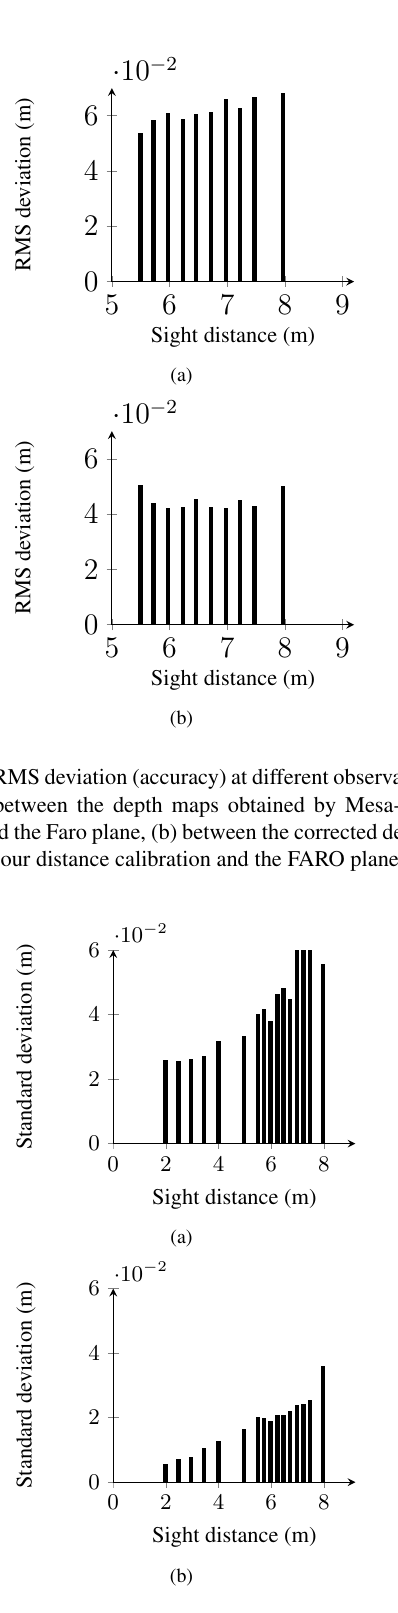
Figure 15. Standard deviation (precision) at different observation distances for (a) the Mesa-Imaging software (b) our calibration method